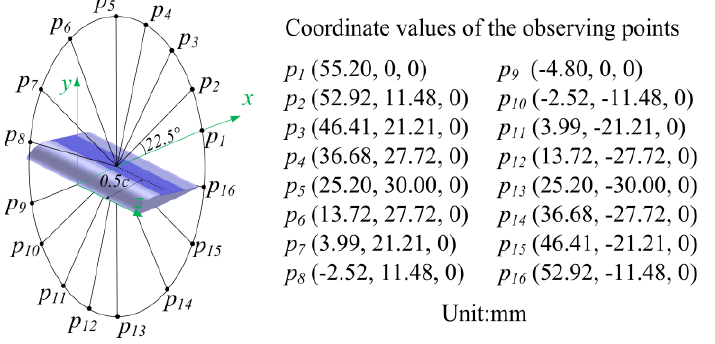
Figure 12. Observing points for near-field SPL computation with 16 locations on the plane x - y . The distance between the origin of the coordinate and the leading edge is 0.5 c.